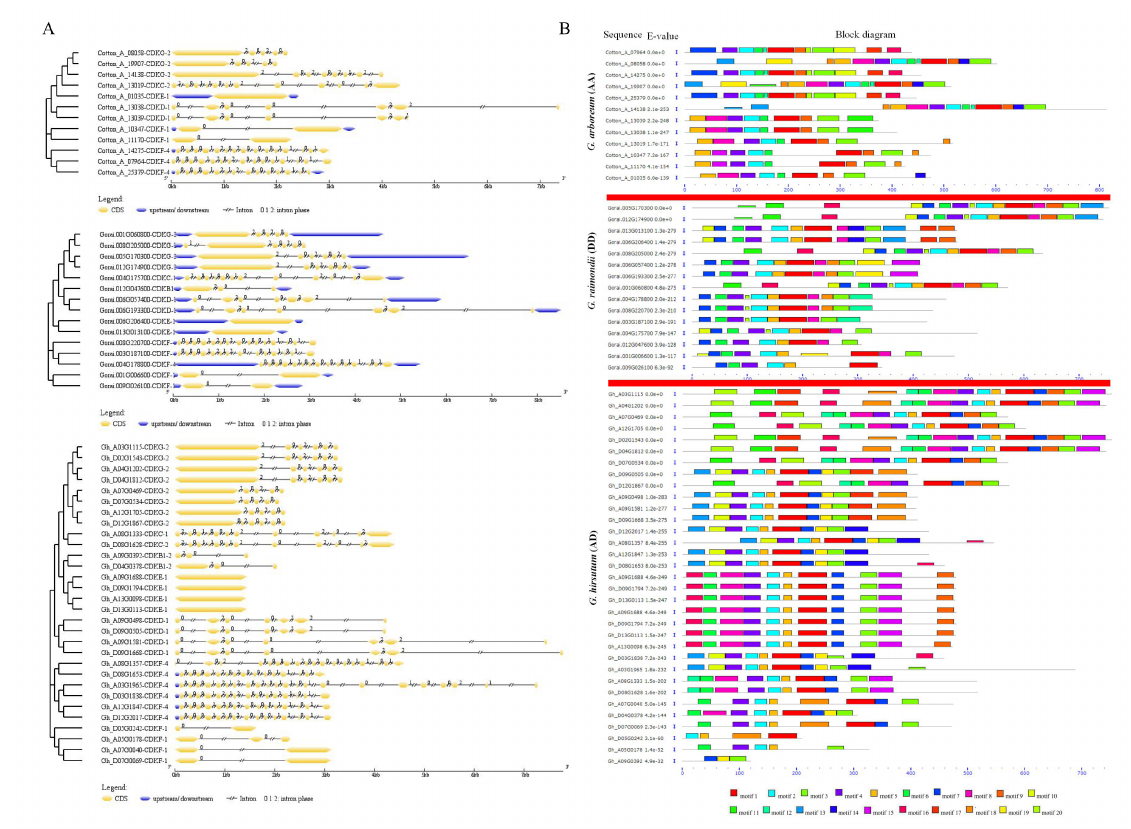
Figure 1. Gene structure and motif compositions of cotton CDK genes. ( A ) Exon/intron structures of CDK genes in cotton, exons introns and up/down-stream were represented by yellow boxes, black lines, and blue boxes, respectively. ( B ) MEME software characterized conserved motifs of G. raimondii (D), G. hirsutum (AD), and G. arboreum (A). Different colors represent different motifs and each motif is represented by a box numbered at the bottom. The names of genes and combined P value are exhibited on the left side of the figure. Grey lines represent the non-conserved sequences; the length of protein can be estimated using the scale at the